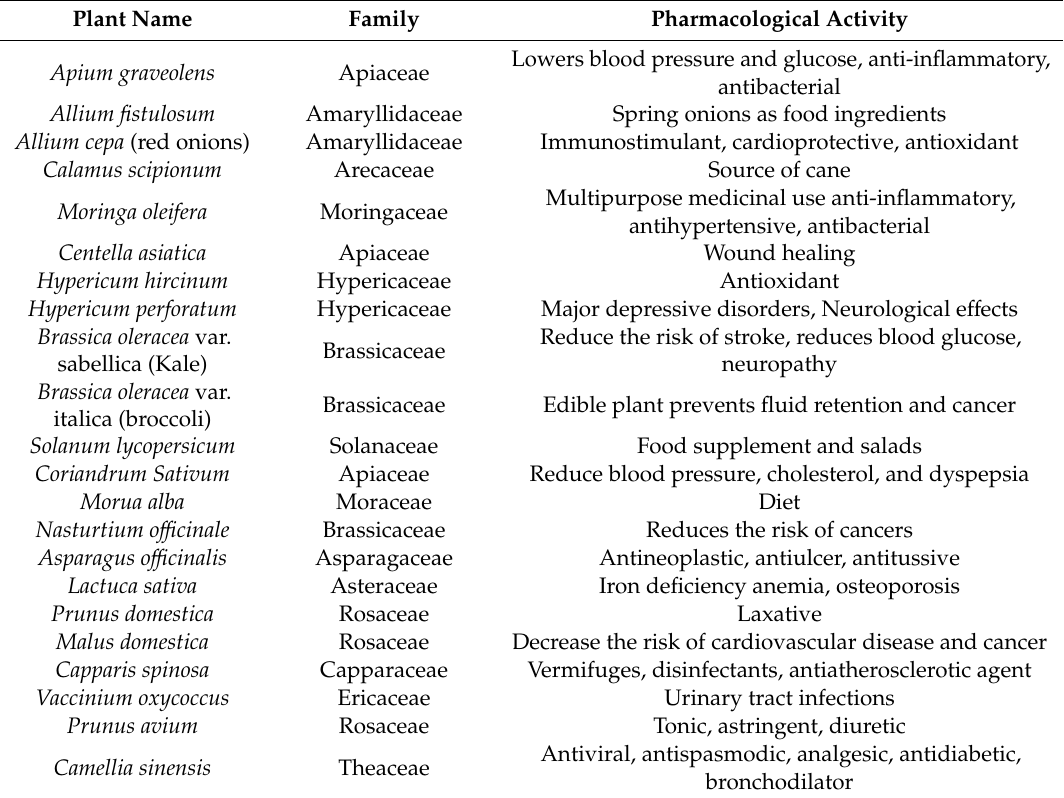
Table 1. Sources of quercetin and its traditional